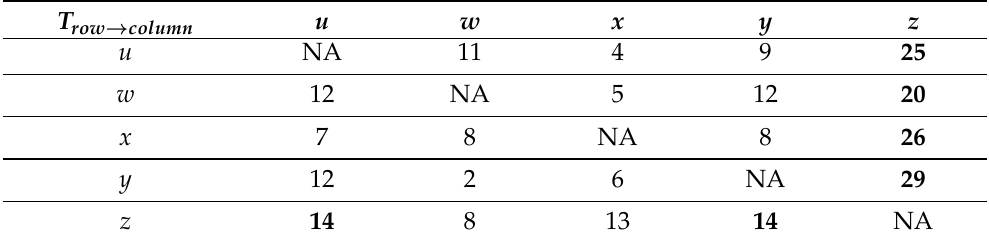
Table 7. Sum of cases where the mean value of the Transfer Entropy coefficient in a row for a given variables pair is the highest—1st variant (49